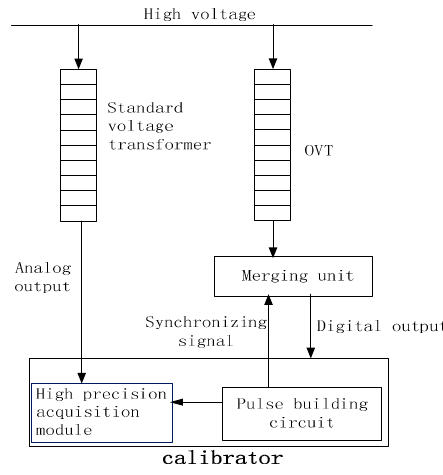
Figure 8. The calibration scheme of OVT in the lab and off-line in the field.